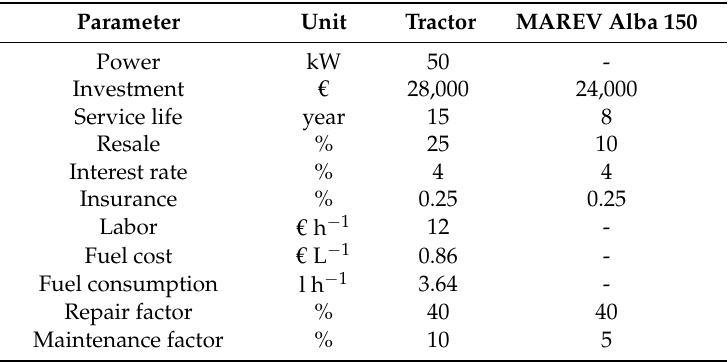
Table 3. Harvesting cost